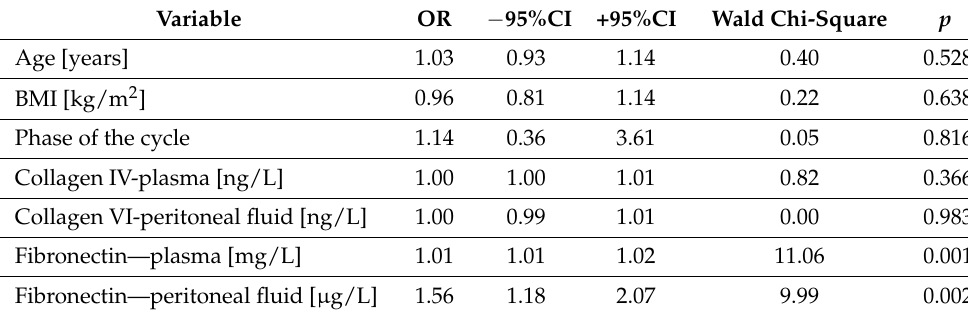
Table 4. Logistic regression for endometriosis OR and 95% CI (n =